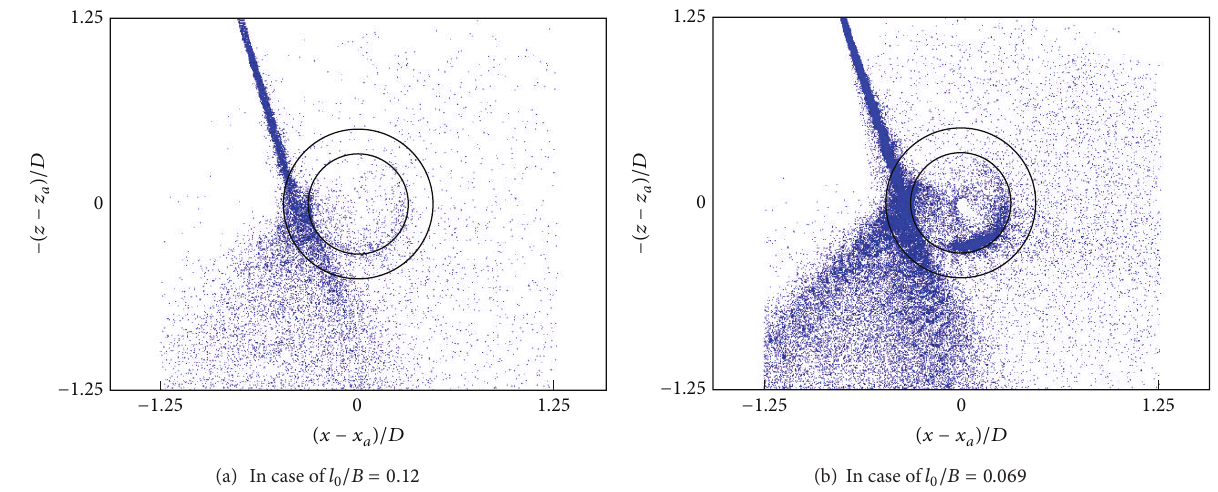
Figure 9: Effect of distance between particles 𝑙 0 on particle distribution when 𝜆 = 0.56